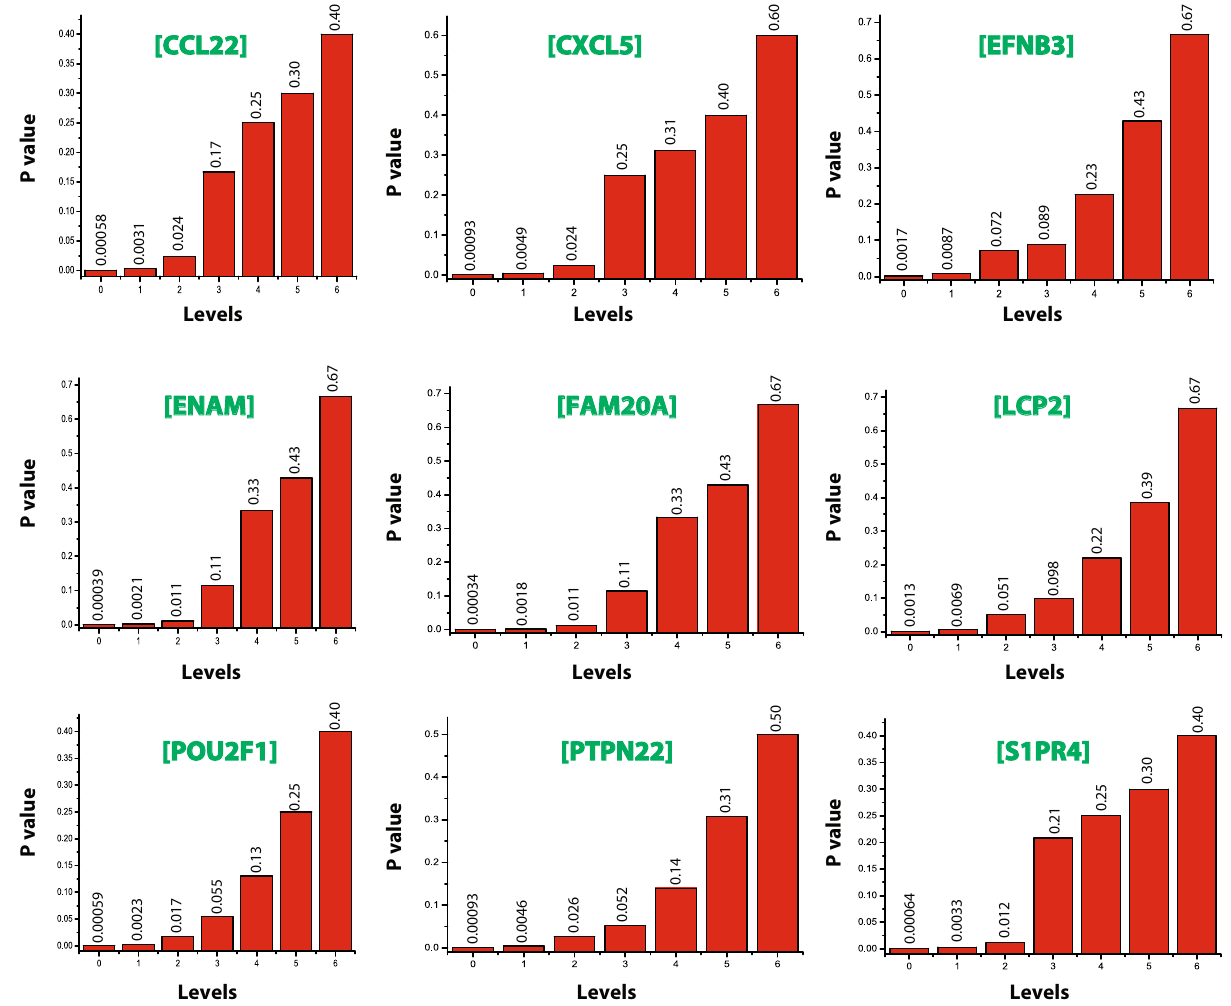
Figure 5. The probability distribution of the KRs as a function of the level.